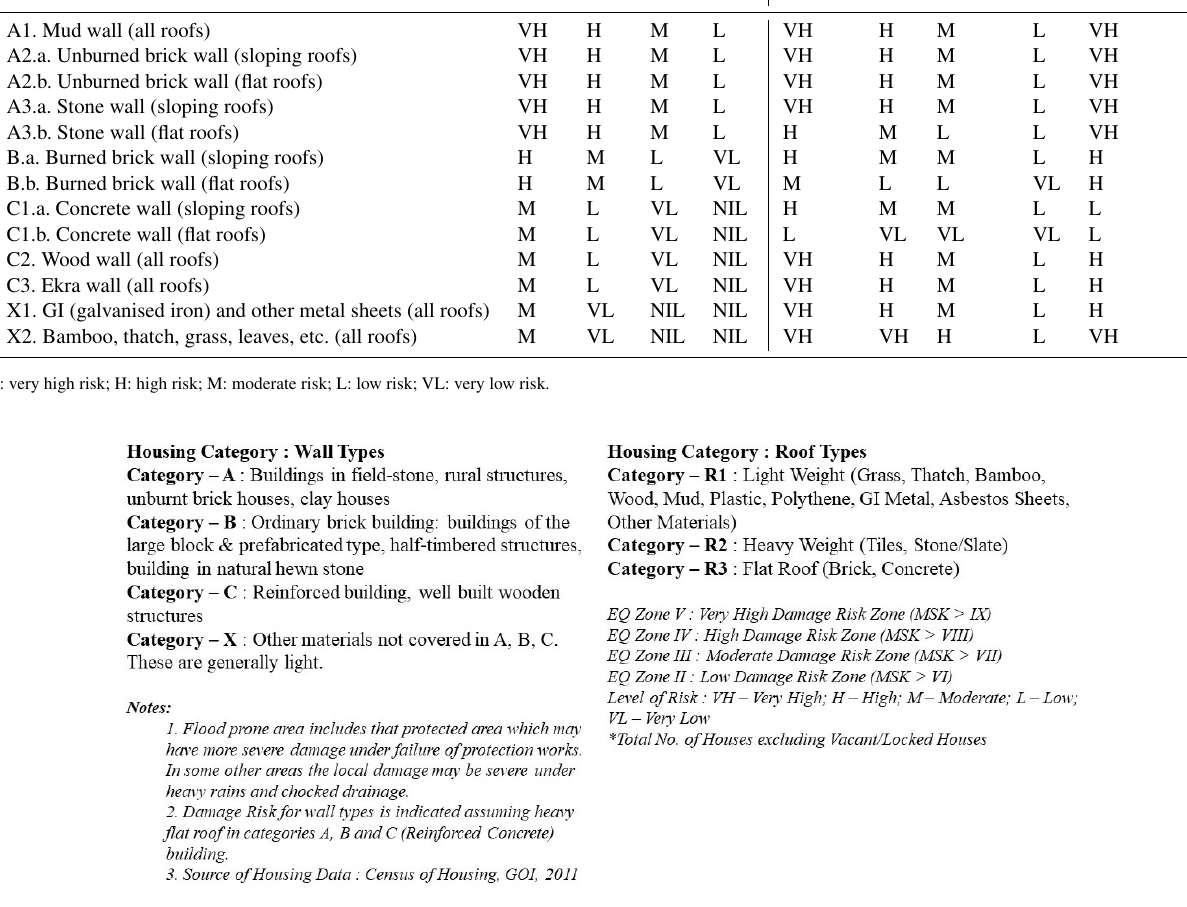
Figure 4. Damage risk and housing category identified by BMTPC (BMTPC,